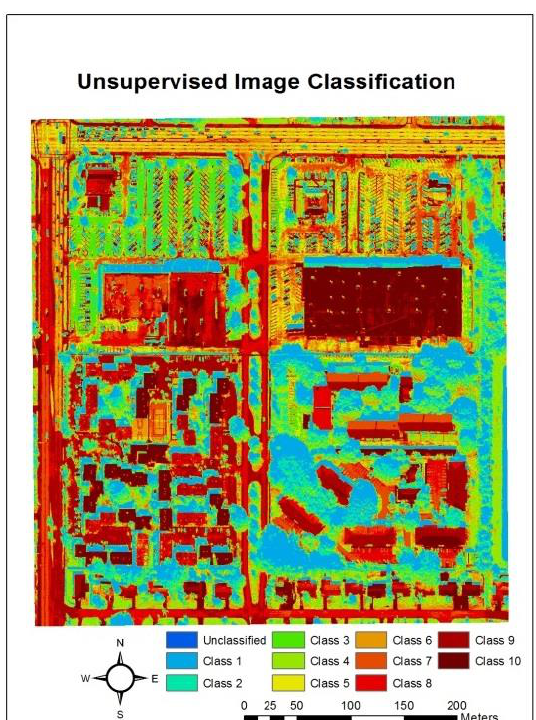
Figure 4. Unsupervised Image Classification for